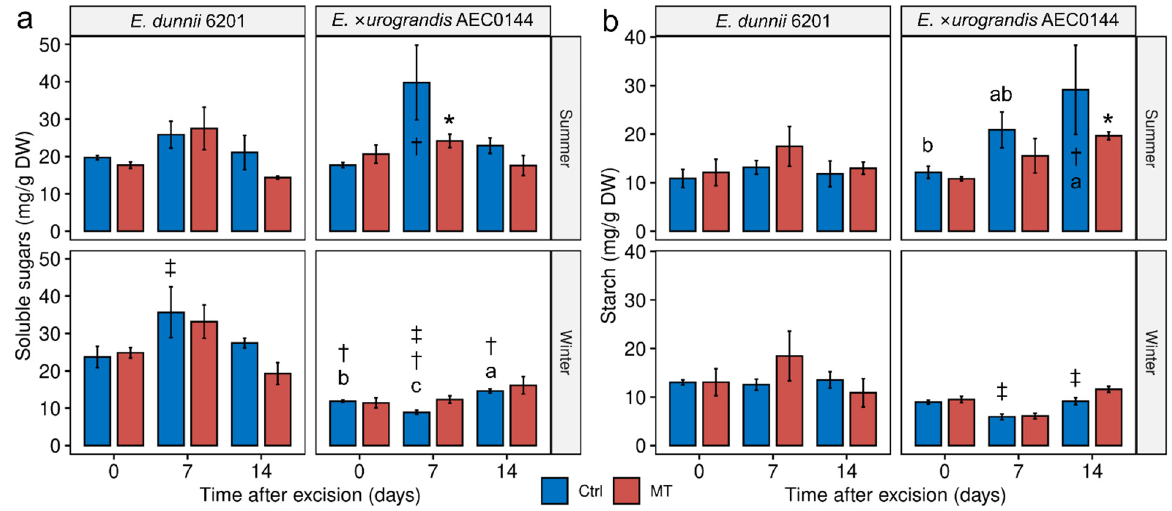
Figure 4. Carbohydrate concentration in Eucalyptus dunnii 6201 (hardR) and E. × urograndis AEC0144 (easyR) cuttings in contrasting seasons. Whole ‐ cutting ( a ) soluble sugar (mg/g DW) and ( b ) starch (mg/g DW) content at 0, 7, and, 14 days post ‐ excision from mini ‐ stumps under control (Ctrl) and mini ‐ tunnel (MT) conditions. Bars represent mean ± SEM ( n = 3). Asterisks (*), daggers (†), and dou ‐ ble daggers (‡) indicate signi fi cant di ff erences between the Ctrl and treatments, between clones in comparison to the Ctrl, and between seasons in comparison to the Ctrl, respectively. Different low ‐ ercase letters indicate Ctrl timewise variation (factorial ANOVA, estimated marginal means test, p ≤ 0.05). DW = dry weight.